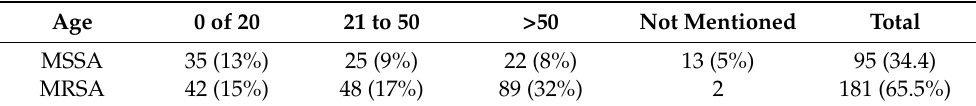
Table 4. Patterns of Staphylococcus aureus lineage infections across different age-groups in Ha’il region, Saudi